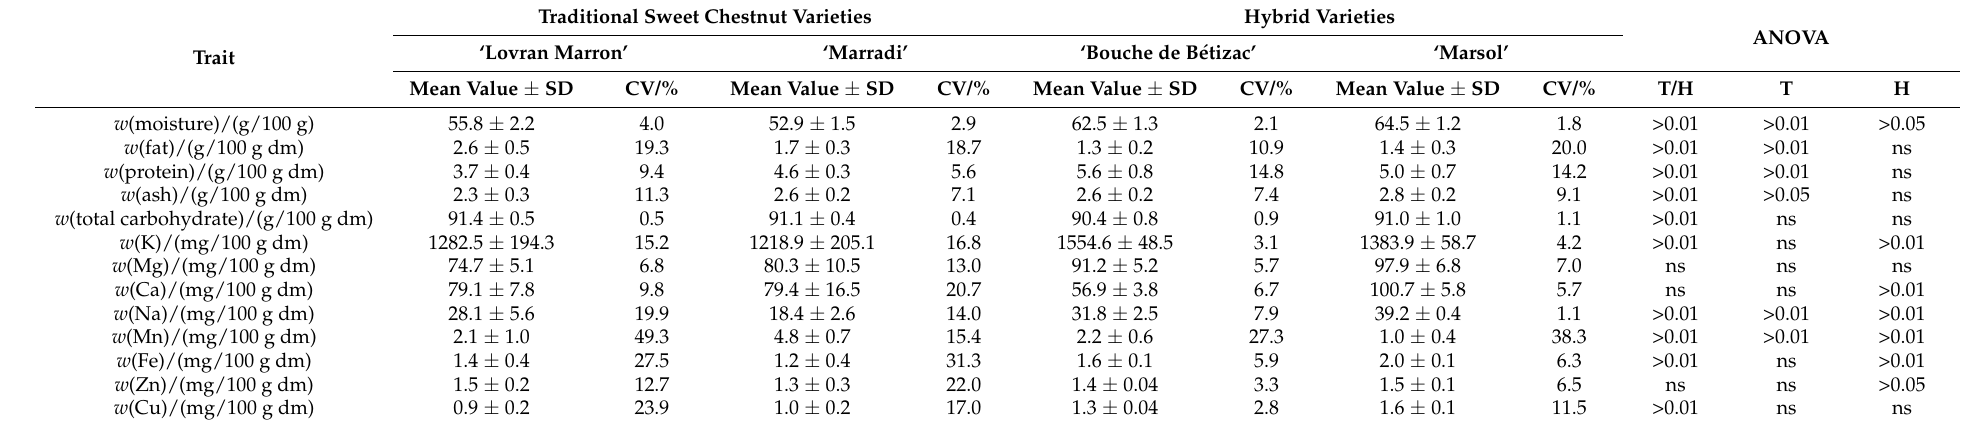
Table 3. Chemical composition—descriptive statistical parameters and levels of